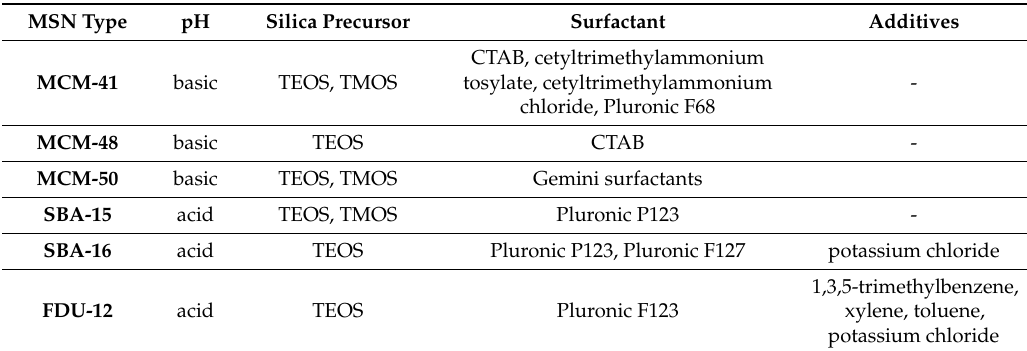
Table 2. The pH, silica precursor, surfactant, and additives required for the synthesis of